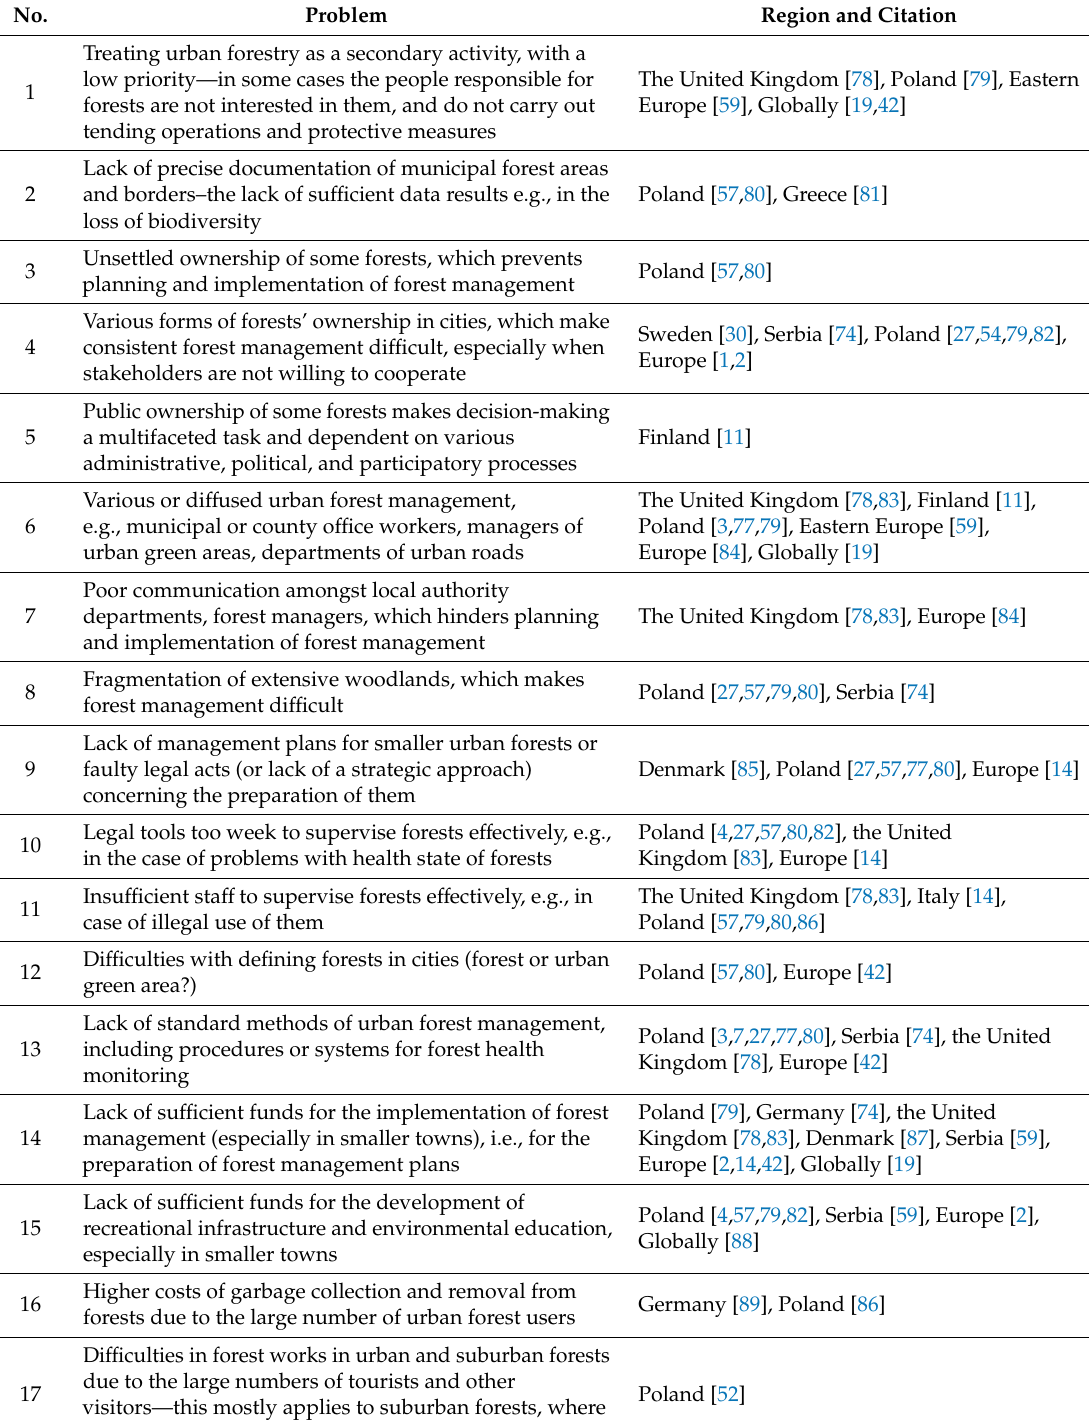
Table 1. Problems of forest management in urban and suburban